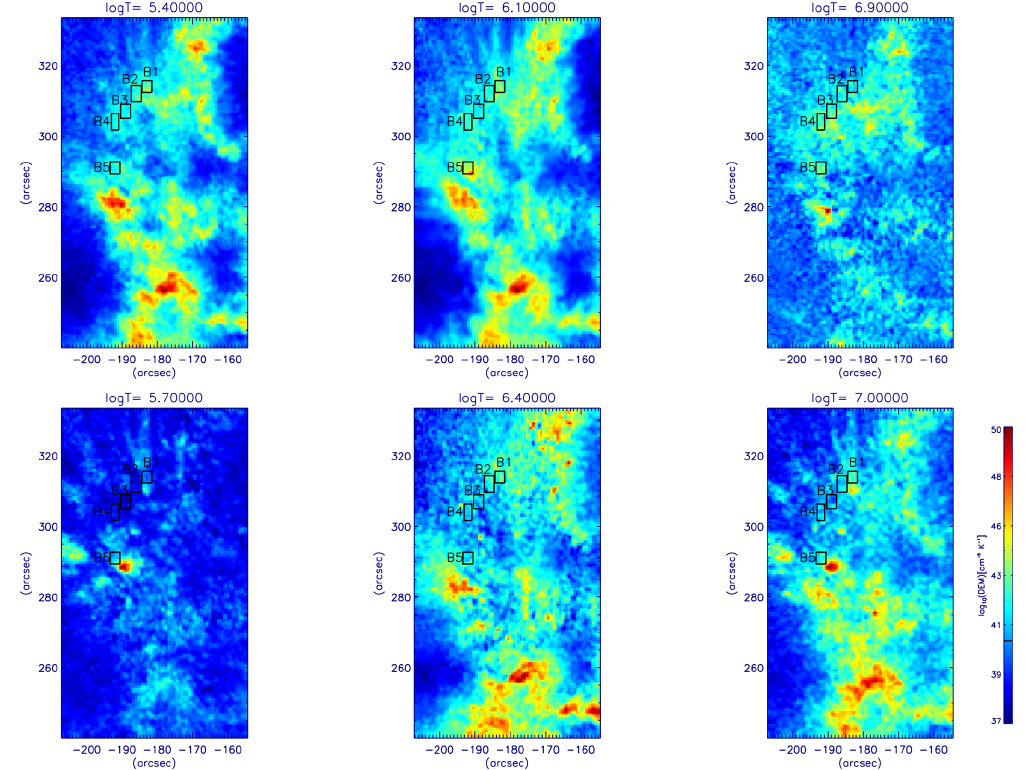
Figure 4. Differential emission measure maps of the plage region containing the moss associated to foot points of quiescent coronal loop systems.